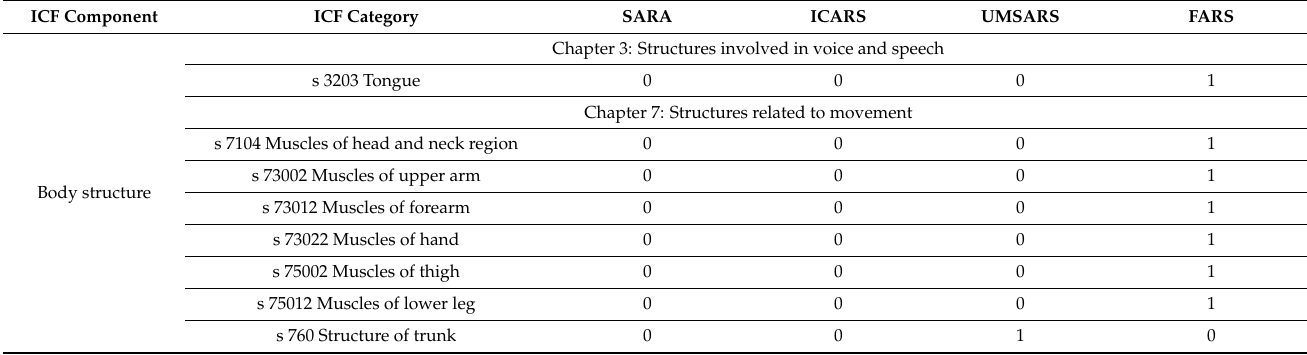
Table 2. Frequencies of ICF categories among the four ataxia rating scales. ICARS, international cooperative ataxia rating scales; FARS, Friedreich’s ataxia rating scale; SARA scale for assessment and rating ataxia; UMSARS, unified multiple system atrophy rating